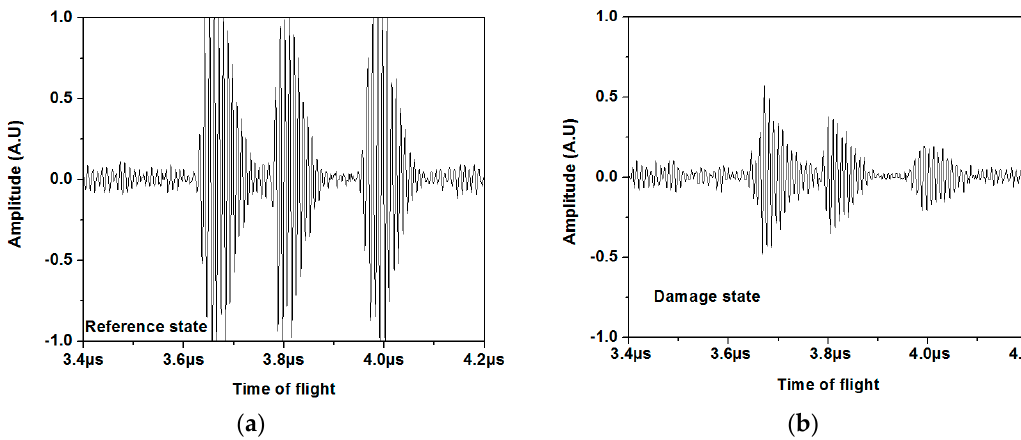
Figure 6. The transient signal of the longitudinal wave ( a ) in reference and ( b ) damaged sensors excited using scanning acoustic microscopy at 100 MHz.